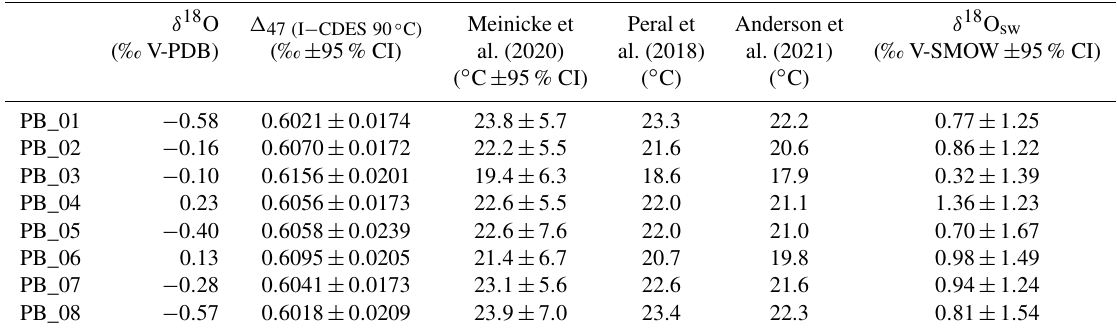
Table 3. Clumped-isotope paleothermometry. Clumped isotopes reconstructed calcification temperatures according to three different cali- brations. The Meinicke et al. (2020) calibration is adopted throughout this work. The δ 18 O sw of seawater was reconstructed by solving the Erez and Luz (1983) equation, using the clumped-isotope calcification temperature and the foraminiferal δ 18 O. Note that all uncertainties in this table refer to 95% confidence intervals (CIs): in the case of calculated clumped-isotope paleotemperatures, these CIs reflect Monte Carlo propagated analytical and calibration